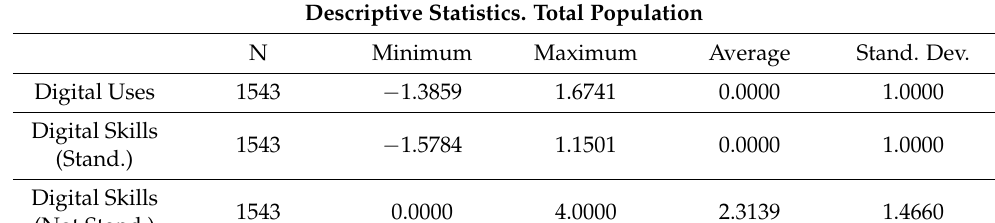
Table 2. Descriptive statistics of the digital variables. Descriptive Statistics. Total